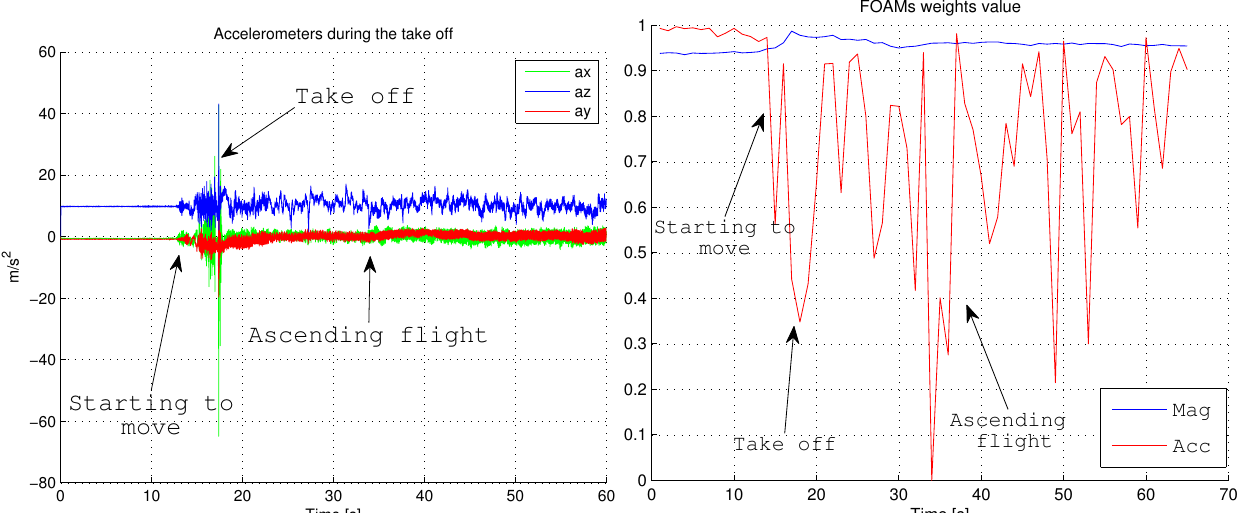
Figure 13. Accelerometers readings and FOAM weights during taking